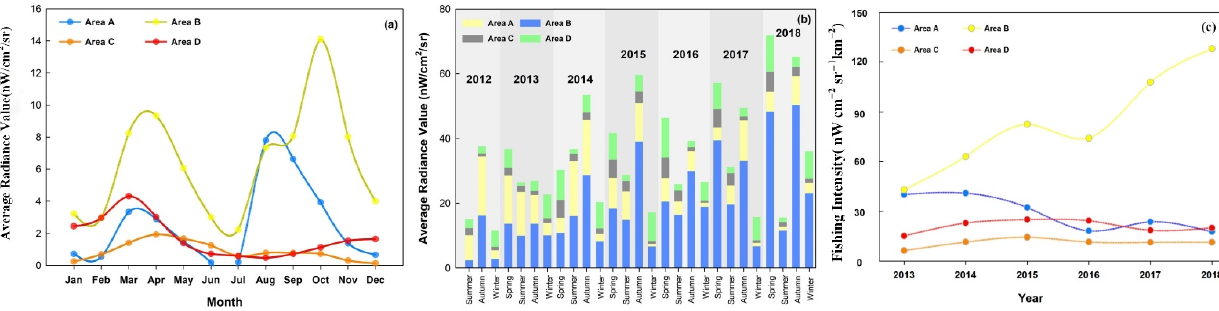
Figure 13. Nighttime fishing intensity pattern in the selected areas ( a ) monthly ( b ) seasonal ( c )